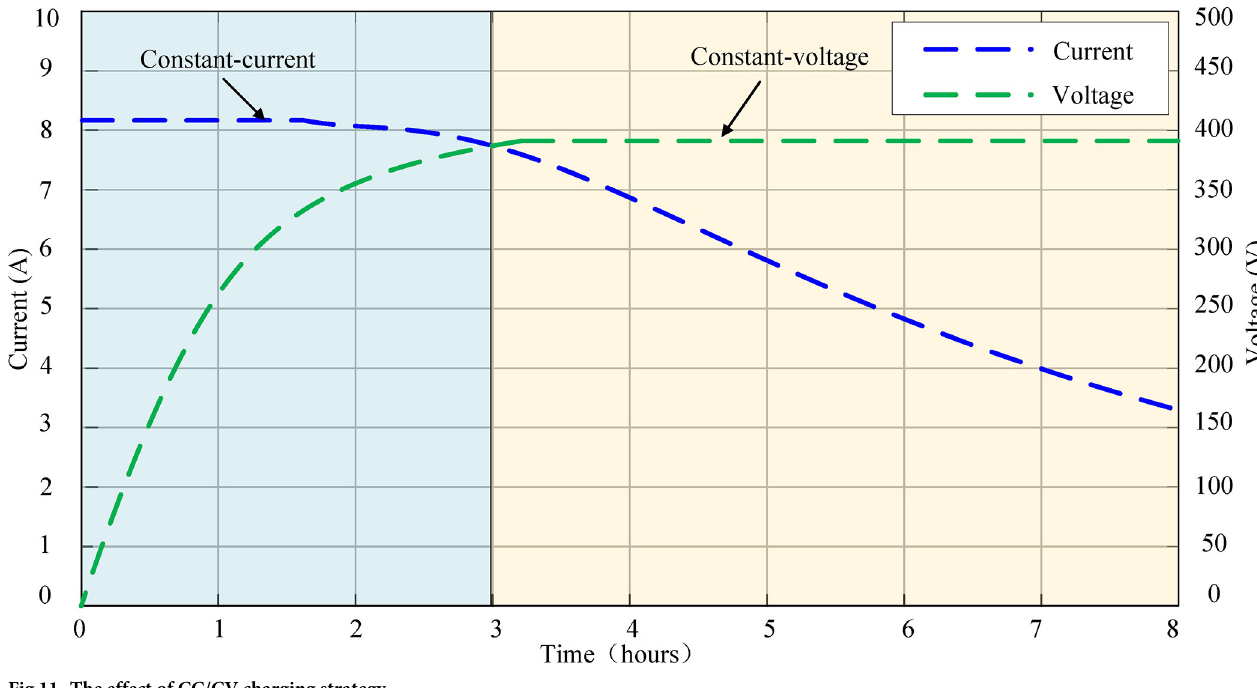
Fig 11. The effect of CC/CV charging strategy.